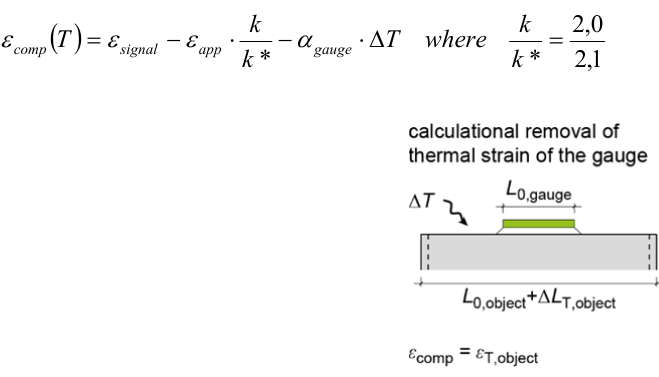
Fig. 7 Removal of the strain of the gauge results in the thermal strain of the